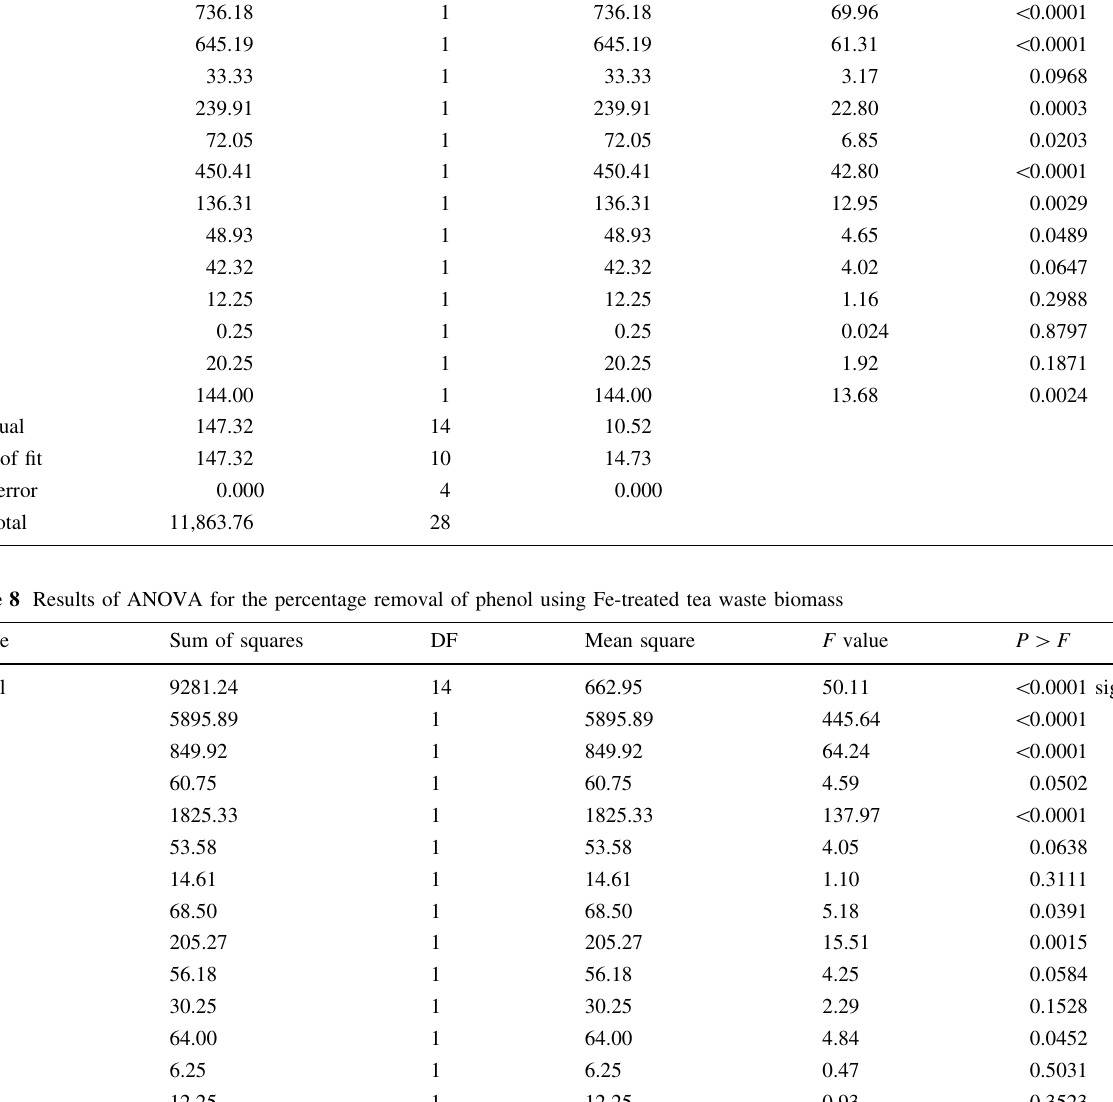
Table 7 Results of ANOVA for the percentage removal of Cr(VI) using Fe-treated tea waste biomass Source Sum of squares